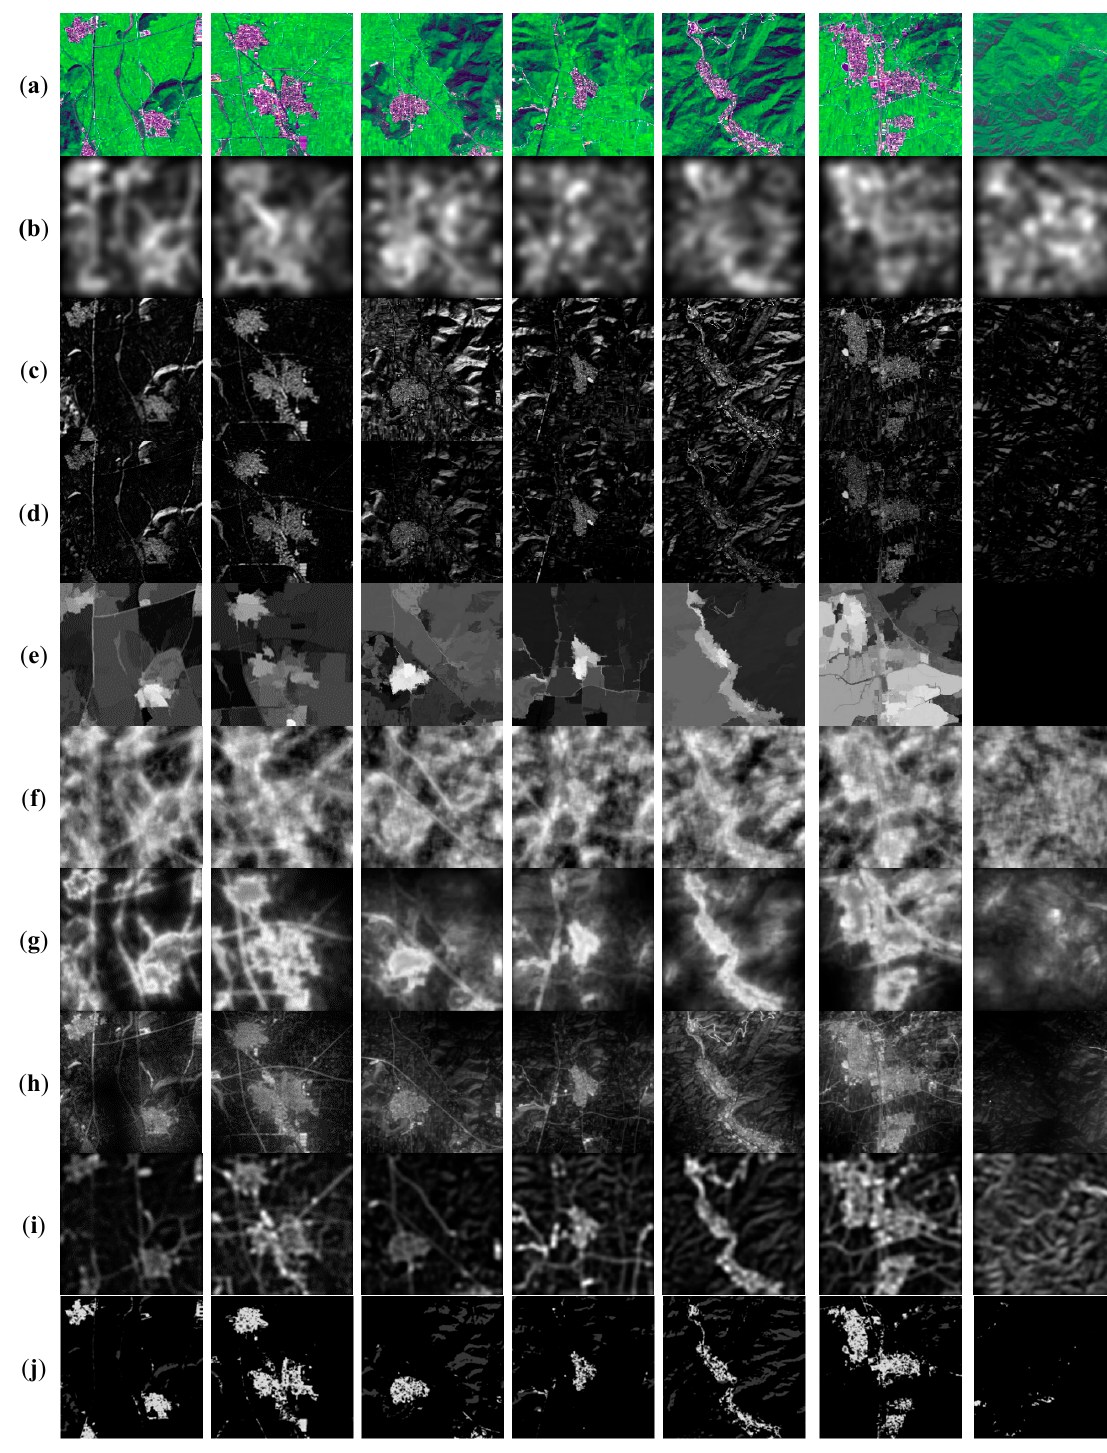
Figure 10. Visual comparison of saliency maps from Group SPOT5 - Residential area . From top to bottom are ( a ) input images; ( b ) ITTI; ( c ) FT; ( d ) MSSS; ( e ) CB; ( f ) SIM; ( g ) CA; ( h ) TMM; ( i ) FDA-SRD; and ( j ) our JMS model.